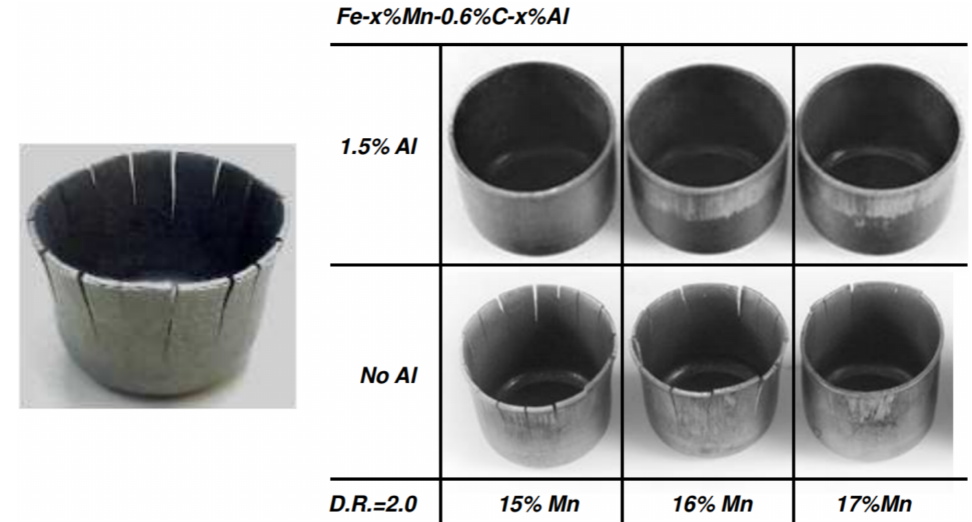
Figure 10. Example of delayed fracture in a deep drawn Fe-22% Mn-0.6% C, TWIP steel cup (top, left). Right, Top row: Suppression of delayed fracture by 1.5% Al addition in deep drawn Fe-xMn-0.6% C, TWIP steel cups having 15, 16 and 17% Mn. Right, bottom row: Cups showing cracks in the same steels without an Al addition due to delayed fracture [5].